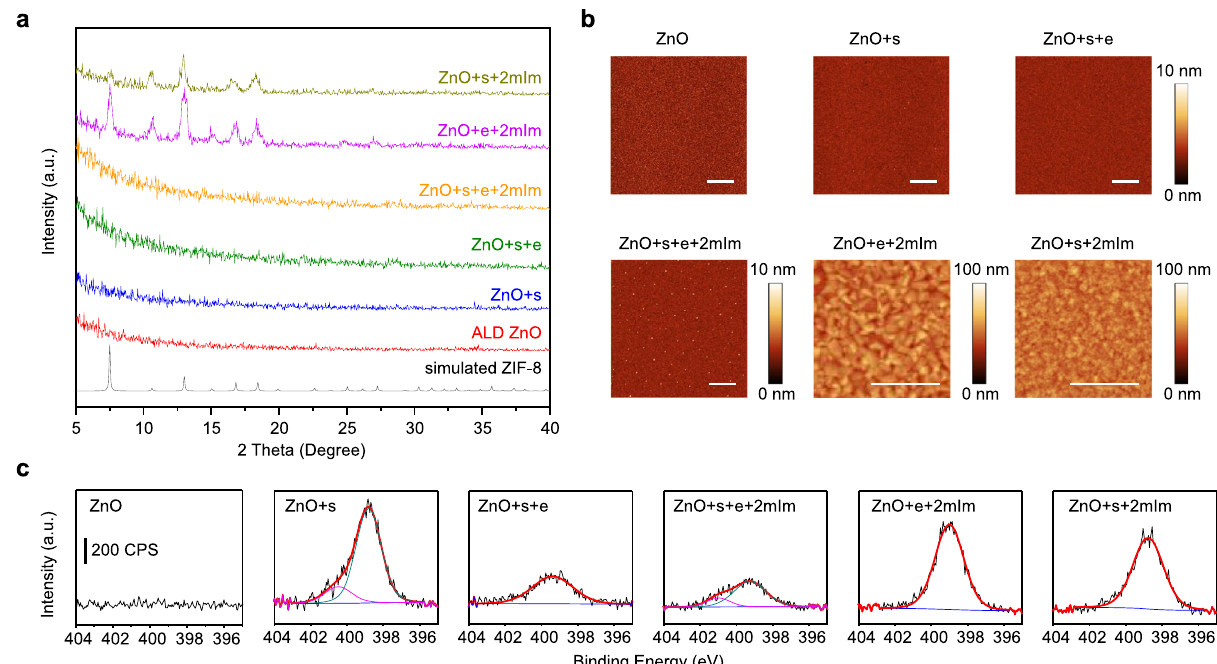
Fig. 4 Characterization of sensitized and e-beam irradiated ZnO samples. a , b GIXD and AFM of a ZnO wafer before and after consecutive treatment of sensitization, e-beam irradiation, and 2mIm treatment. Samples are denoted to indicate the processing steps used, s: sensitization with 2mIm at 50 °C for 1 h; e: e-beam irradiation at 2 kV, 20 mC cm − 2 ; 2mIm: vapor treatment with 2mIm at 120 °C for 15 min. GIXD patterns were collected at a 0.15° incidence angle. c . N 1 s XPS of samples corresponding to a . Scale bars are 1 µ m.